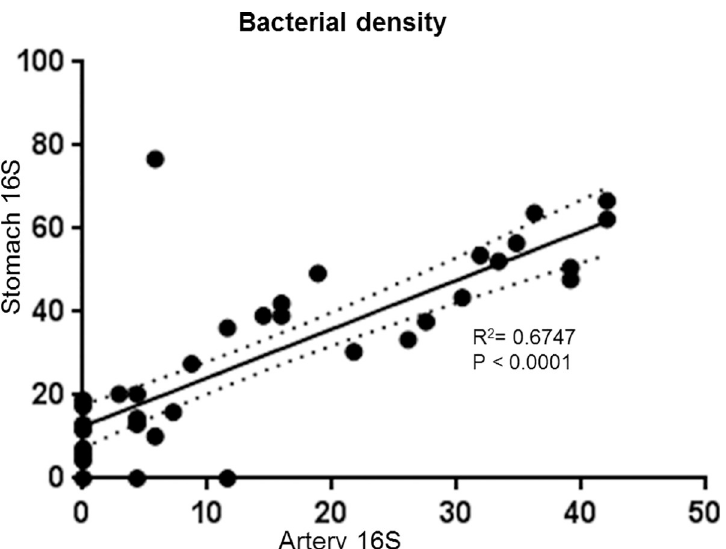
Fig 7. The density of H . pylori in the stomach correlates with the density in the left circumflex coronary artery. H . pylori density was determined by counting the number of bacteria per field (as determined by 16S rRNA in situ hybridization) and is expressed as bacteria per 10 6 μ m 3 . Only H . pylori positive animals with both stomach and artery data are included in the analysis (n = 44). Solid line, linear regression best fit; dotted line, 95% confidence interval; R 2 , coefficient of determination.